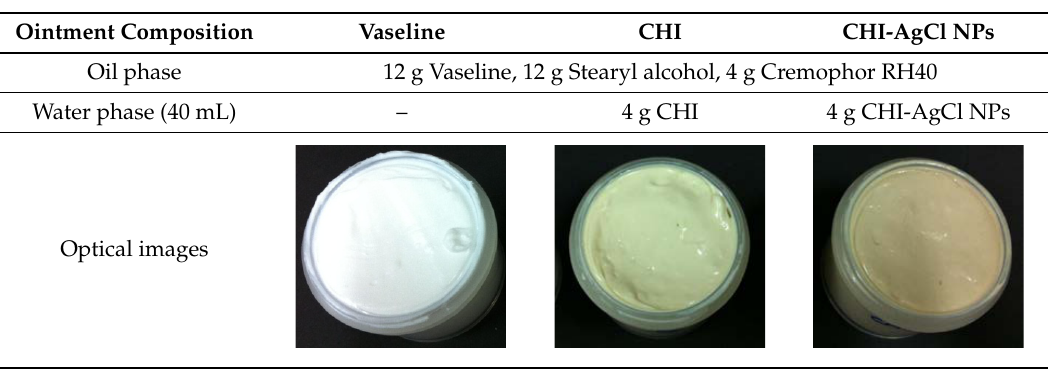
Table 1. The composition of each ointment for in-vivo burn wound healing in the rats.